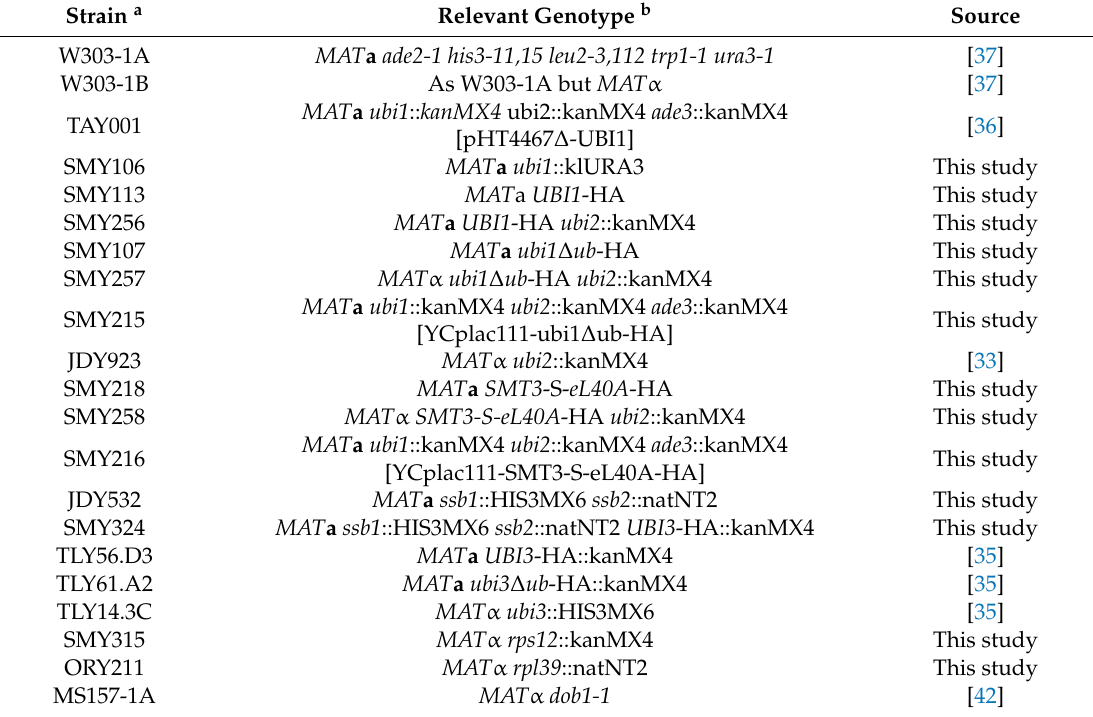
Table 1. Yeast strains used in this